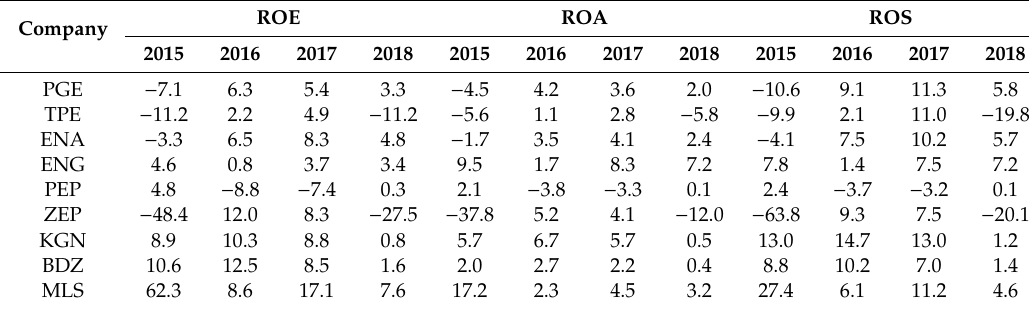
Table 3. Profitability ratios of the examined companies.